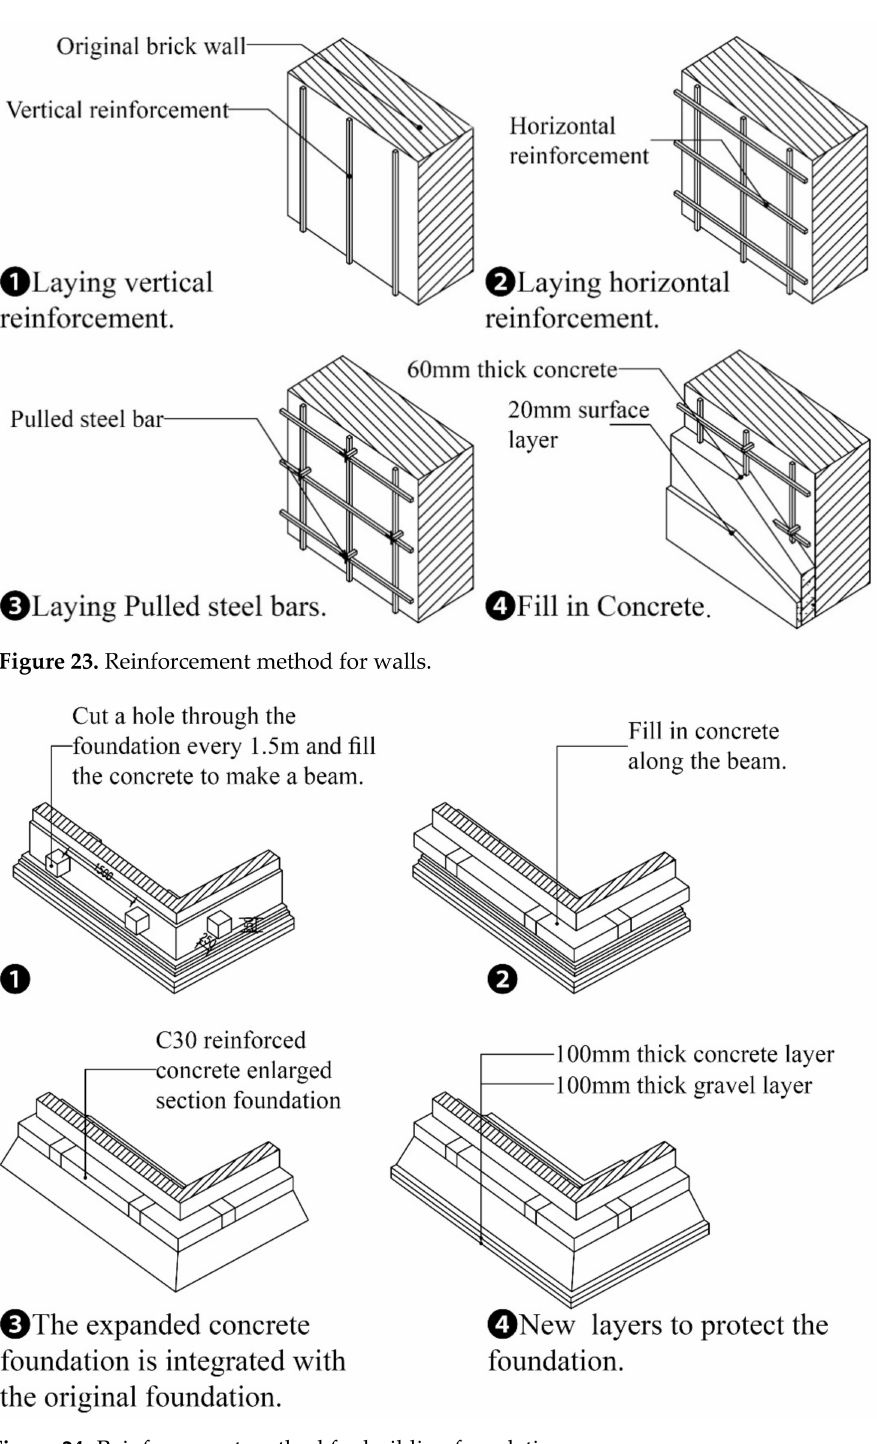
Figure 24. Reinforcement method for building